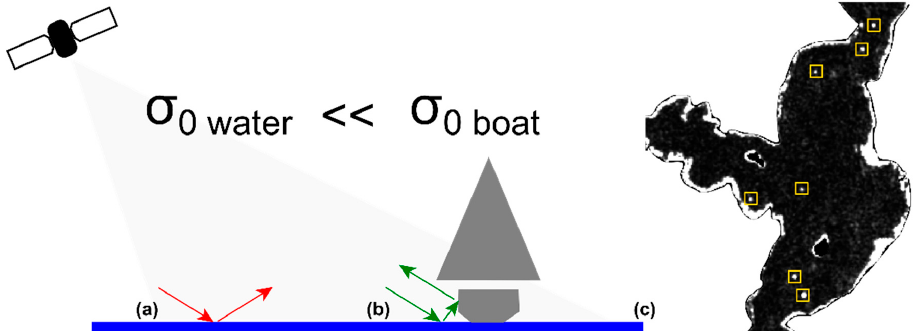
Figure 3. Boat detection method: ( a ) a single specular bounce from the water, ( b ) a double bounce from the boat ( σ 0 —backscatter), and ( c ) a sample radar satellite image (yellow squares represent boats). Extraction of boat candidates. VV polarization images were selected for boat